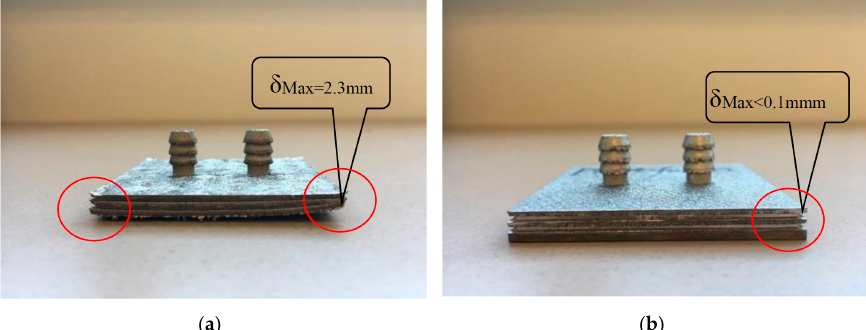
Figure 11. Physical thermal deformation of forming: ( a ) serious deformation; ( b ) ordinary deformation.